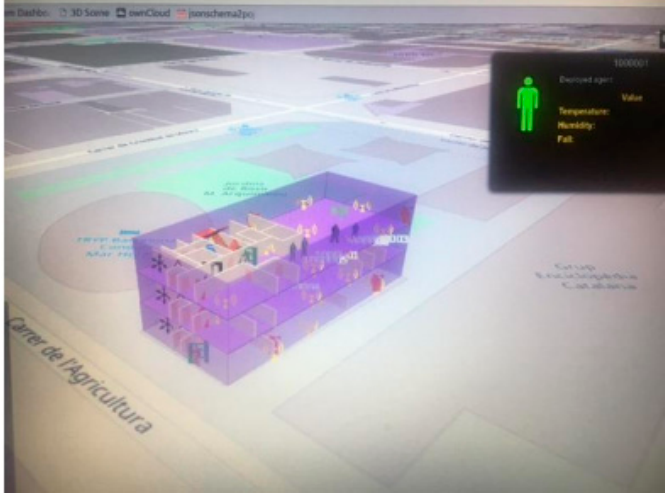
Figure 3. T hree-dimensional model of a reconstructed